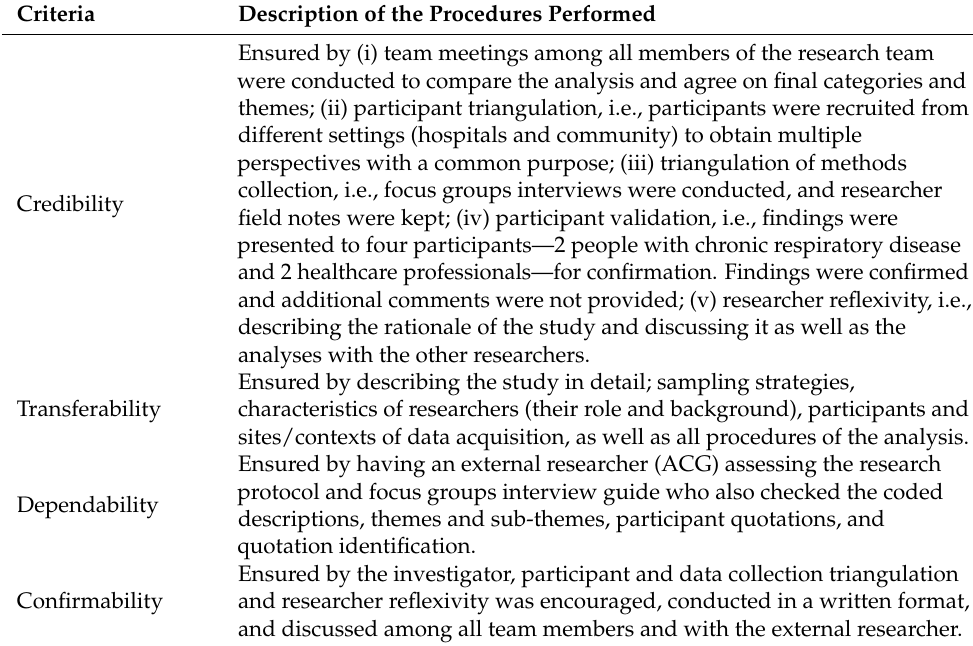
Table 1. Procedures to ensure trustworthiness of analysis and